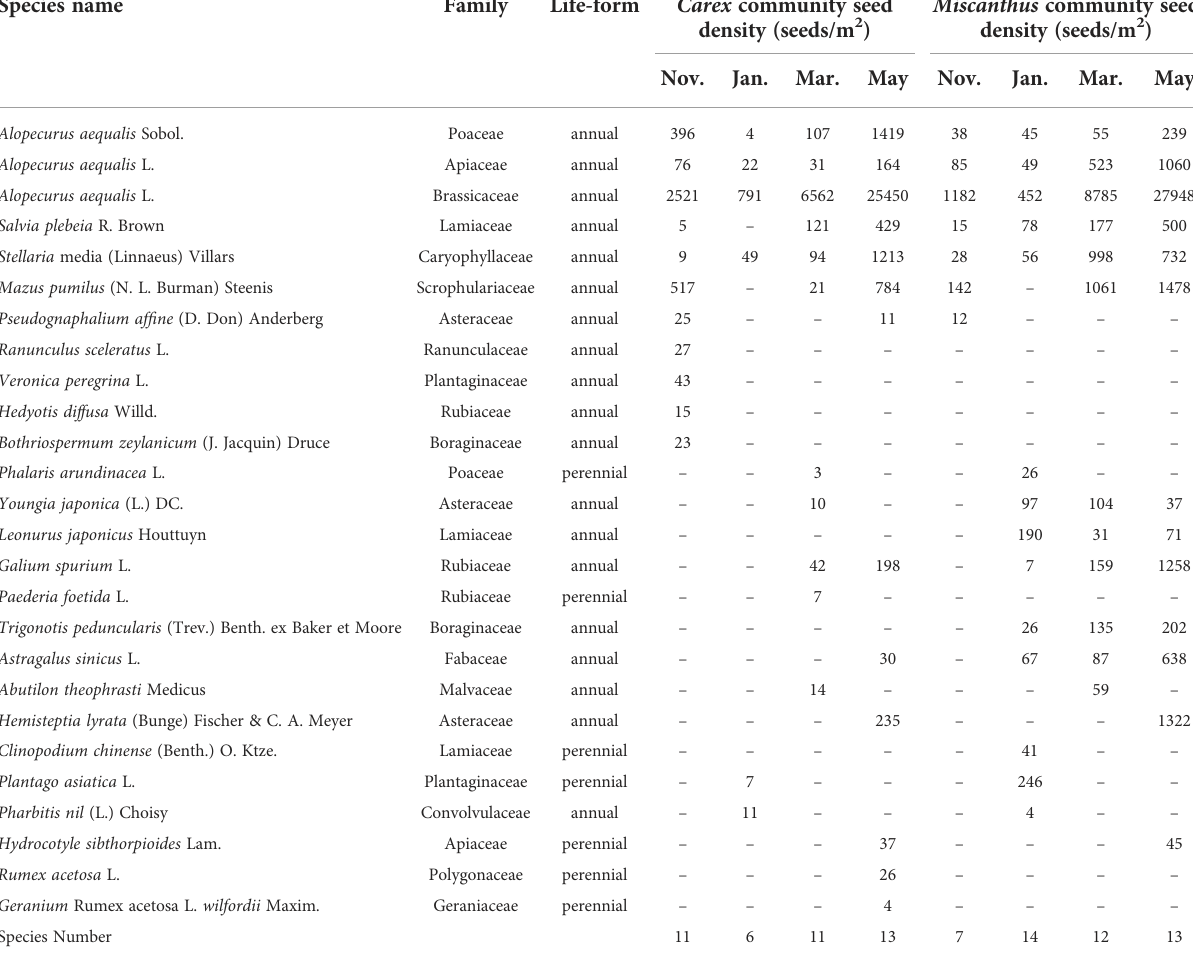
TABLE 2 Species composition and seed density in the seed banks of Carex and Miscanthus communities in different sampling periods at the Dongting Lake